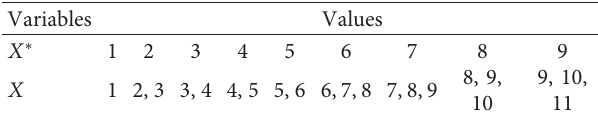
Table 1: The corresponding values of X and X ∗ if X ∗ ≤ 9.